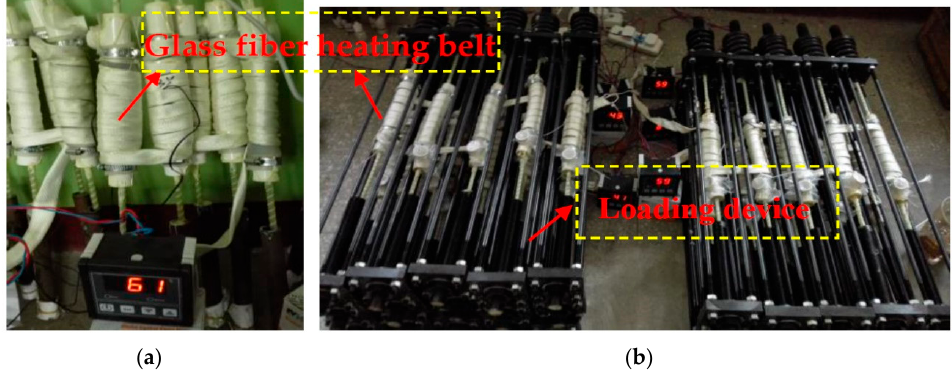
Figure 3. Temperature control measures: ( a ) Unstressed specimens and ( b ) stressed